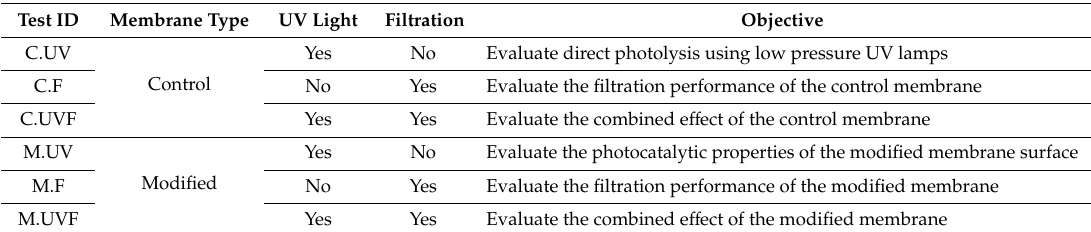
Table 2. Description of the six tests performed in the submerged photocatalytic membrane reactor.